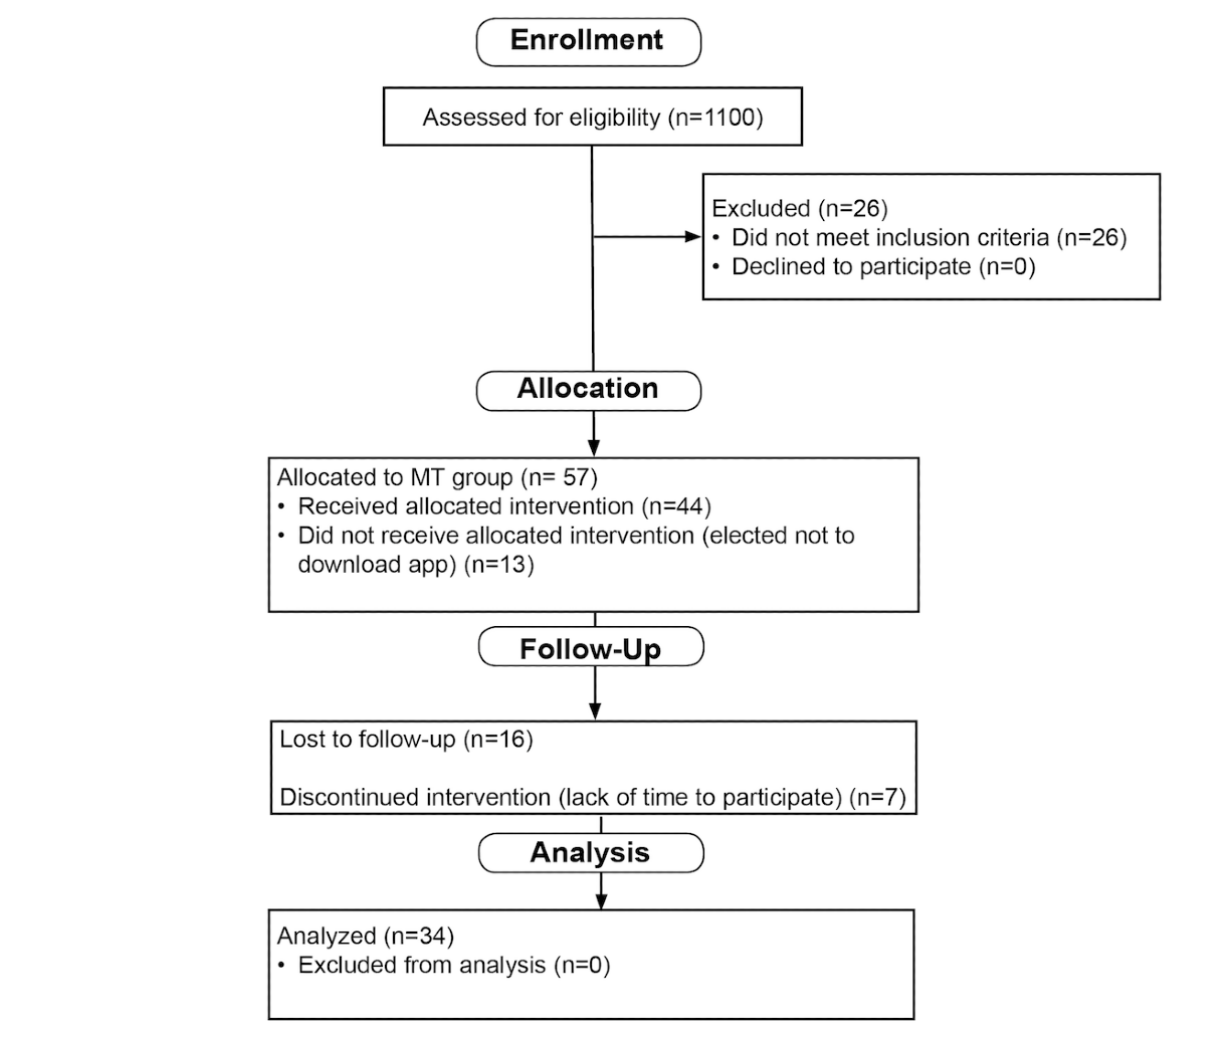
Figure 2. Consolidated Standards of Reporting Trials diagram. MT: mindfulness training.